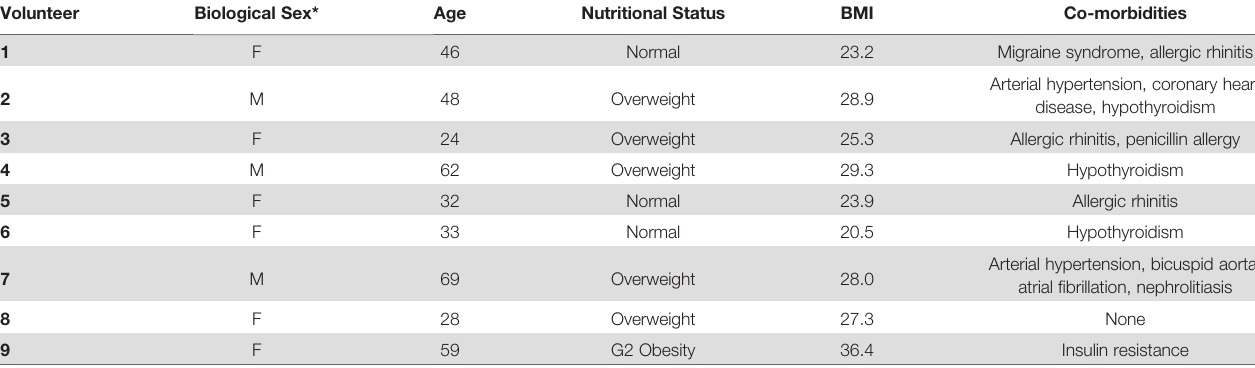
*Gray shading, female; no shading,